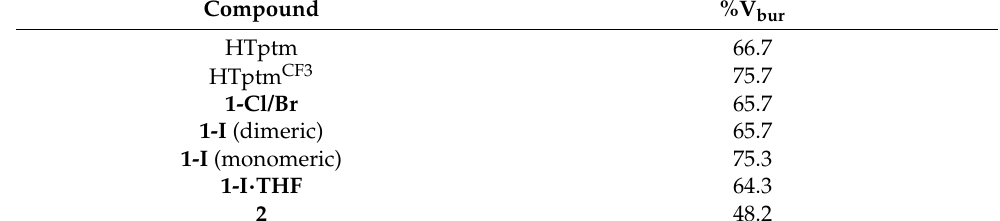
Figure 9. Steric map of the Tptm in 1-X (dimeric, clockwise from top left: X = Cl, Br, I), and monomeric 1-I (bottom left). Generated from buried volume calculations with a coordination sphere of 3.5 Å.